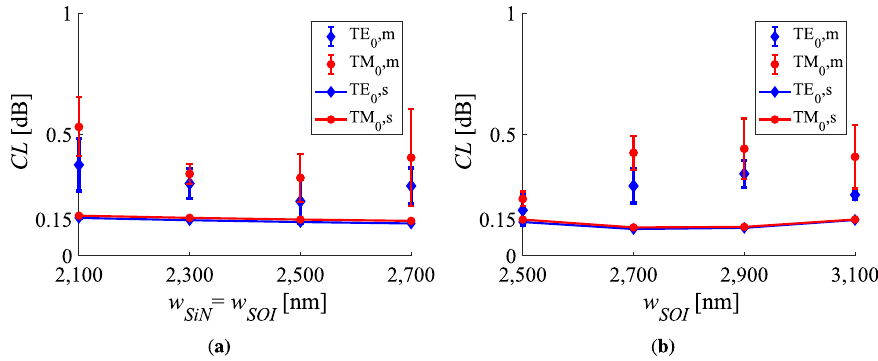
Figure 4. Characterisation data for the fundamental TE and TM modes, along with the simulated values at (cid:31) = 1310 nm . (a) Coupling loss under varying width of the interface, when the two waveguides have equal widths and (b) varying width of the SOI waveguide, when the width of the SiN waveguide is set at 2.5 µ m . The angle of the interface is set at 0 ◦ . The index m denotes measurement data, while s corresponds to simulation results. The characterisation data and the error bars refer to the mean value and the standard deviation of the cut-back losses,